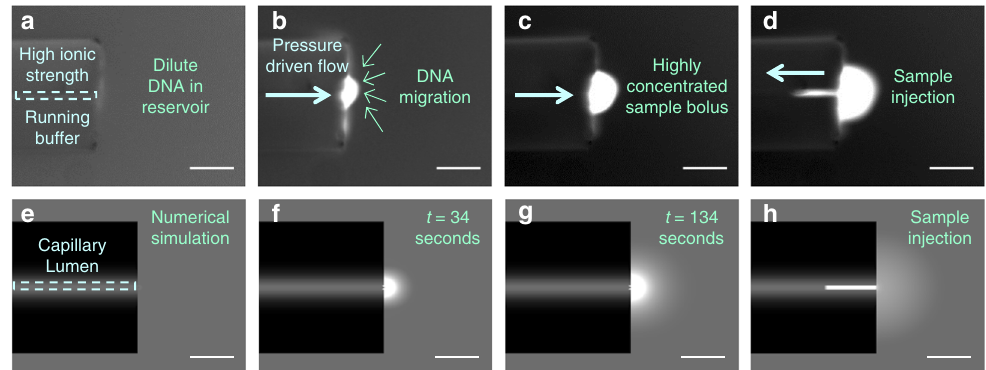
Fig. 1 DNA preconcentration and injection into a microcapillary. a – c Snapshots capture DNA preconcentration at the outlet of a 5 μ m inner diameter microcapillary when pressure is applied to drive fl ow of a high ionic strength solution out of the capillary and into the low concentration reservoir. d The bolus of concentrated DNA can be injected into the capillary by quickly reversing the fl ow direction. e – h The numerical simulation qualitatively captures the behavior of the DNA molecules in response to pressure-driven fl ow and the imposed buffer mismatch at the 5 μ m capillary outlet. Scale bars are 50 μ